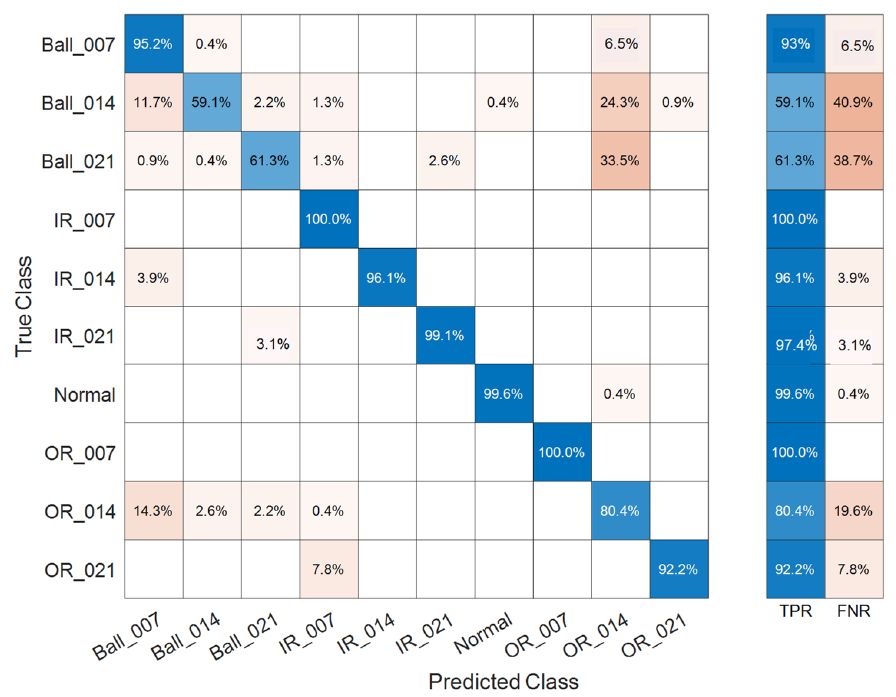
Figure 11. Confusion matrix of motor bearing failure prediction in coarse Gaussian SVM on the noisy environment, with a total accuracy of 88.3%.